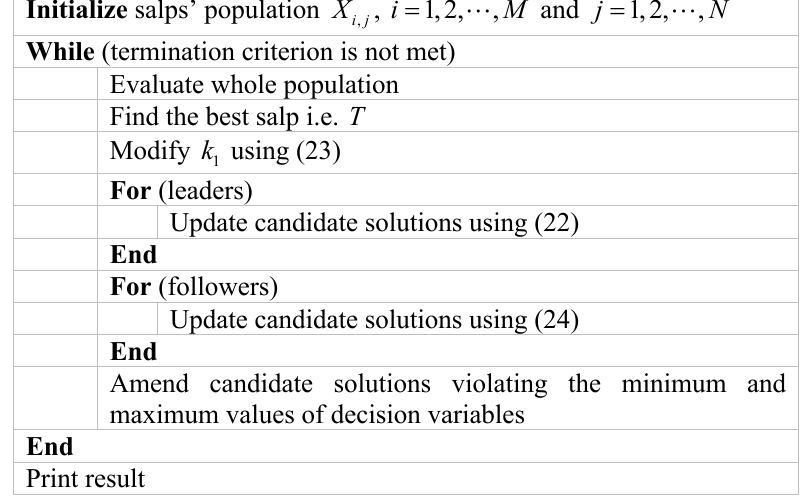
Table 1: Pseudo Code of SSO Algorithm